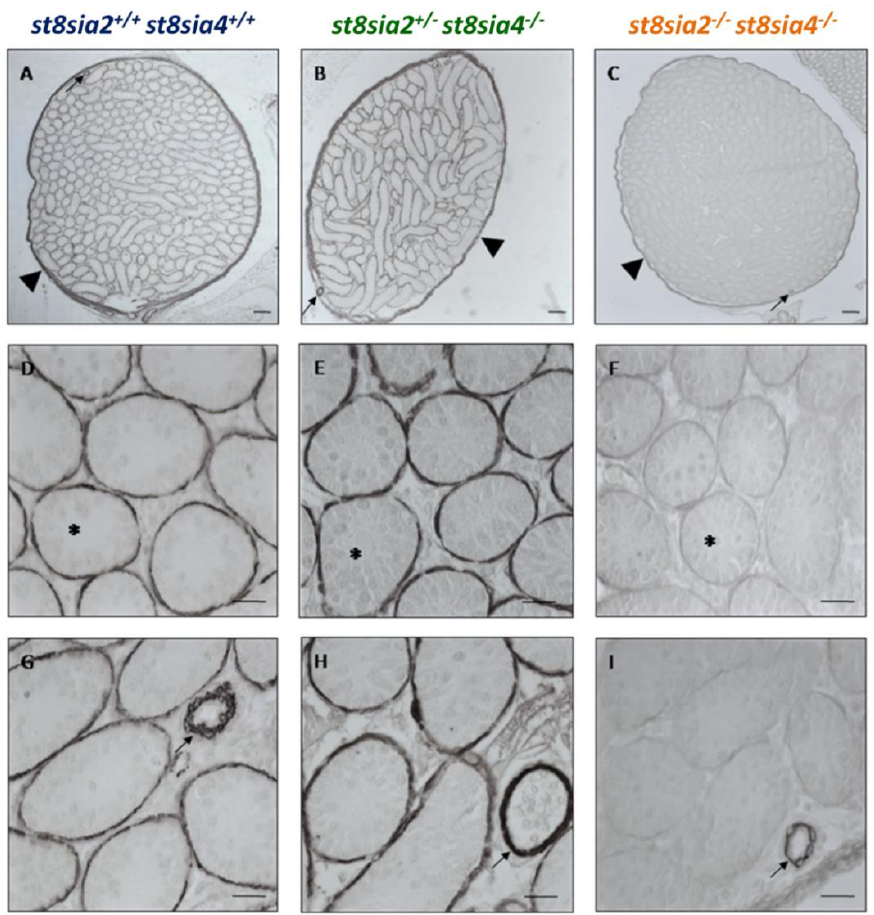
Figure 3. Immunohistochemical localization of SMA in testicular tissue of postnatal mice. The testicular tissue sections of postnatal wild-type ( st8sia2 +/+ ; st8sia4 +/+ ), st8sia2 +/ − ; st8sia4 − / − , and polysialyltransferase-deficient ( st8sia2 − / − ; st8sia4 − / − ) mice were stained with a mAb against SMA. ( A – C ) The tunica albuginea is labeled with a triangle, and selected tubules are marked with asterisks. Arrows indicate blood vessels. Scale bars: ( A – C ) 100 µm; ( D – I ) 20μm. Negative controls are provided in Supplemental Figure S1.